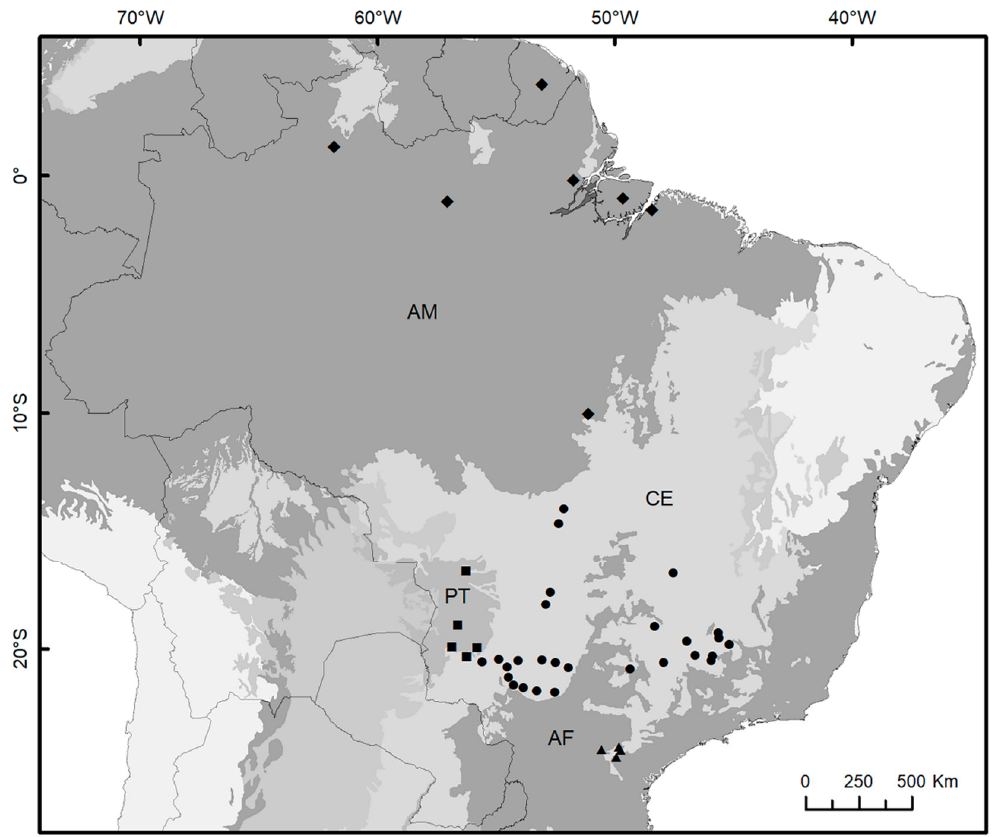
Figure 1. Map of Brazilian biomes showing the sampling localities. Atlantic Forest (AF, triangles); Amazon (AM, diamonds); Cerrado (CE, circles); Pantanal (PT, squares).